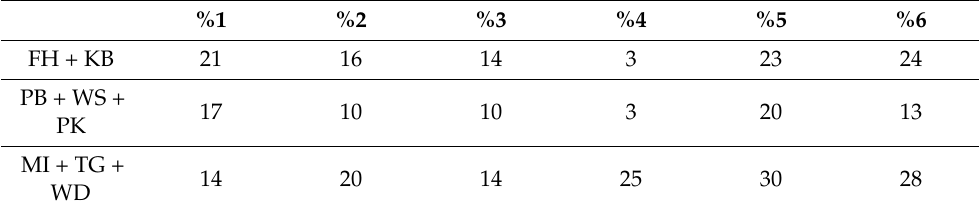
Table 4. Comparison of bicycle mode share in district groups and percentage of total bicycle collisions with a motorized vehicle, by bicycle road type in Berlin (N =